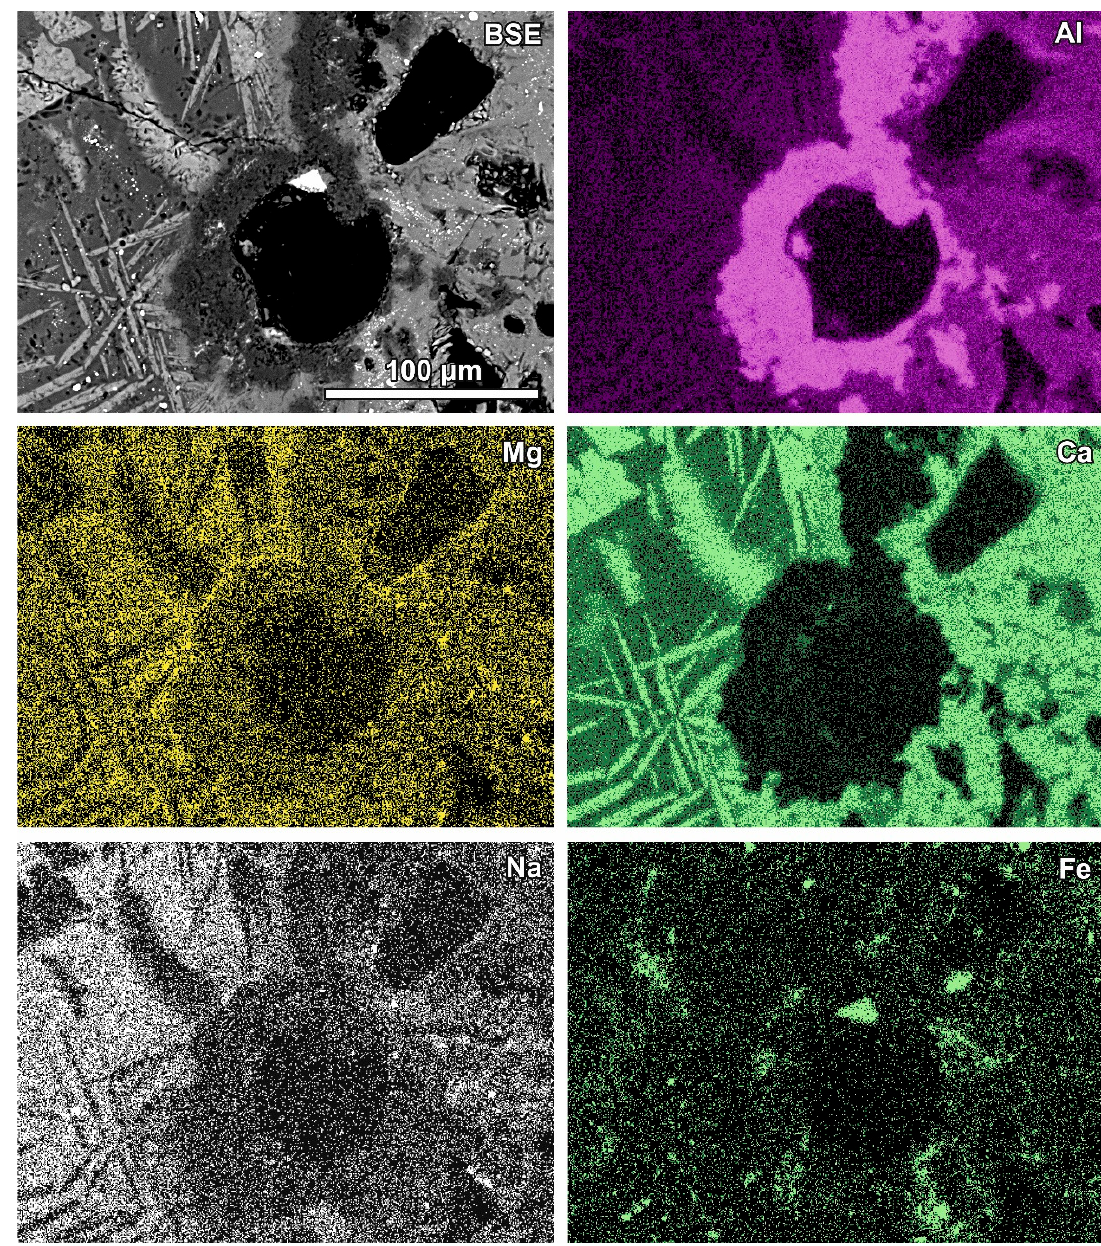
Figure 4. Al-rich irregular fragments (dark grey in the SEM BSE image) around voids in glassy material; BSE and selected elements’ distribution images (sample RZ11).